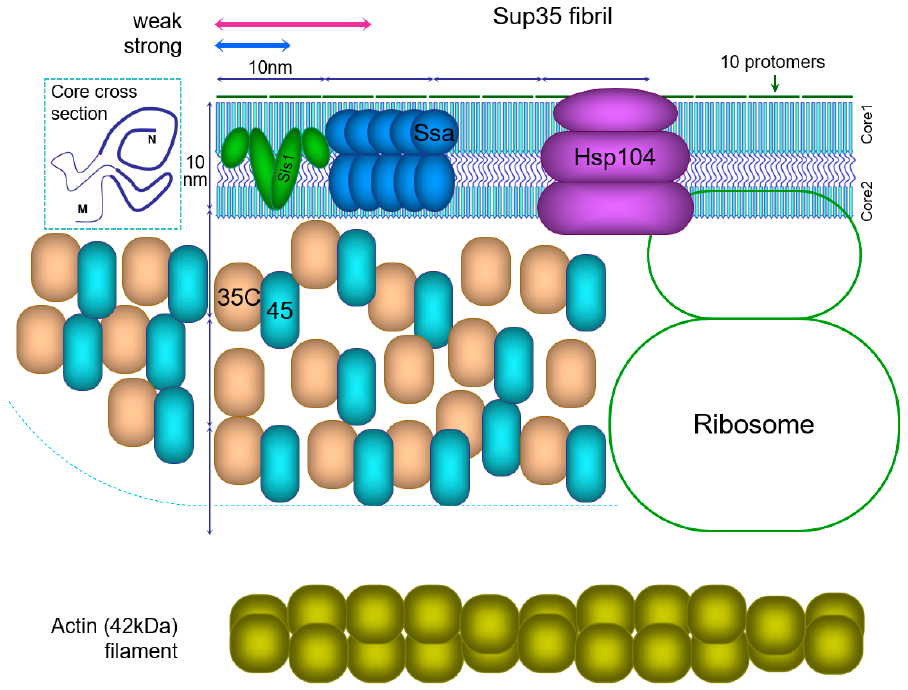
Figure 1. Schematic structure of the Sup35 prion fibril and associated proteins. All sizes are drawn to scale. A possible cross-section of the fibril core is presented in the top left corner, with PK-resistant cores shown by thick lines. For the Sup35 fibril the PK-resistant Cores 1 and 2 are shown joined by an unfolded region, but the M domain is not shown. The actual number of Sup35C (35C) domains together with Sup45 (45) protein should be 4-fold higher than shown. Sup45 is bound to many but not all Sup35C domains. A long Sup35 fibril is shown, but the approximate size of Sup35 prion fibrils is indicated above by arrows: 10–30 protomers for strong [ PSI +] or 20–50 for weak [114]. Sis1 chaperone dimer is likely to be present at one per ten protomers, and the Ssa chaperones at one per two protomers [27,112], but only half of